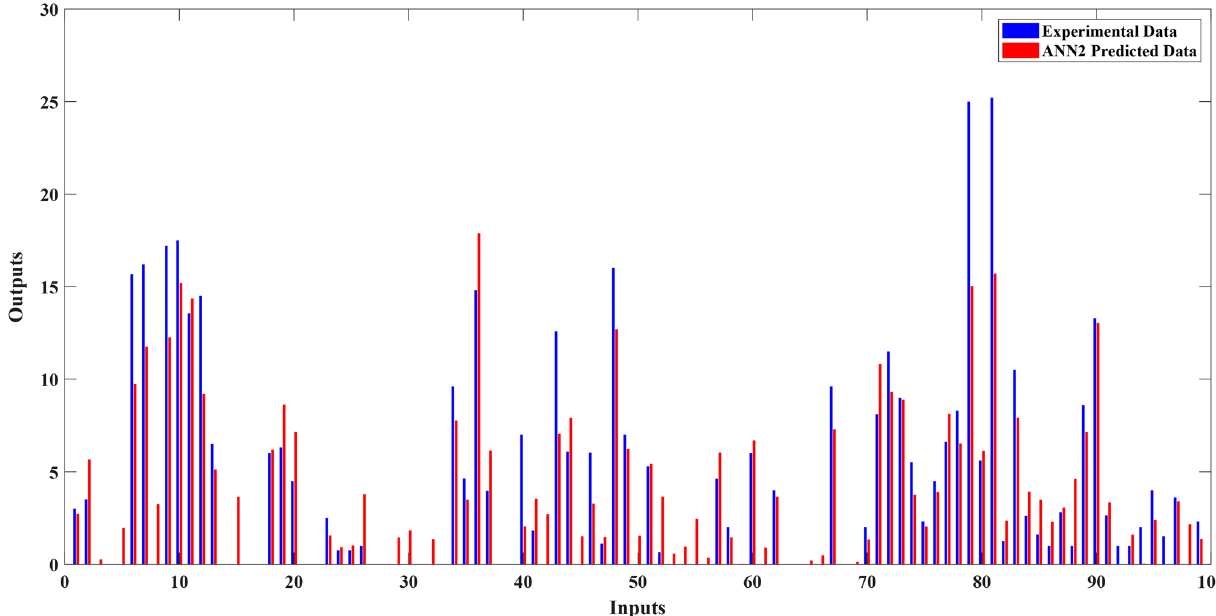
Fig. 27 The performance evaluation of Model No.2 (ANN 2) based on the predicted and experimental